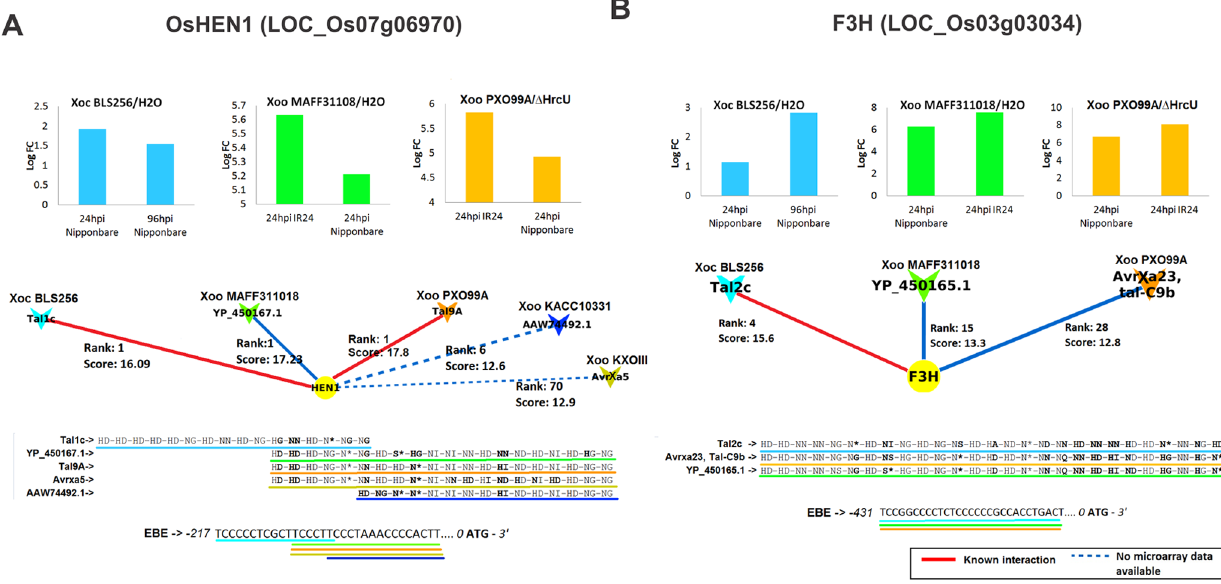
Figure 7. Possible functional convergence on specific rice TALE targets between X.oryzae pathovars. Panels ( A ) and ( B ) summarize Talvez predictions and expression data respectively for OsHen1 and F3H (LOC_Os03g03034). See legend of Figure 6 for details.